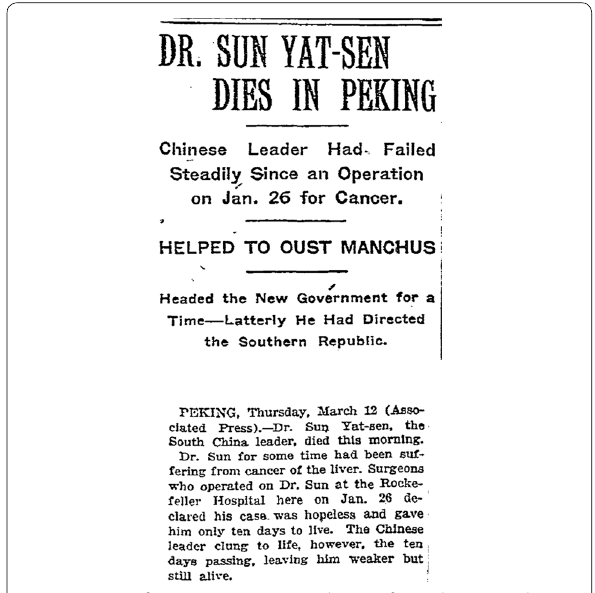
Fig. 4 Representative photomicrographs of a an adenocarcinoma of the gallbladder and b a hepatocellular carcinoma (magnification fact that Dr. Sun’s tumor was highly invasive of the liver and had metastasized to a number of different organs suggests that it could have been a poorly differentiated adenocarcinoma